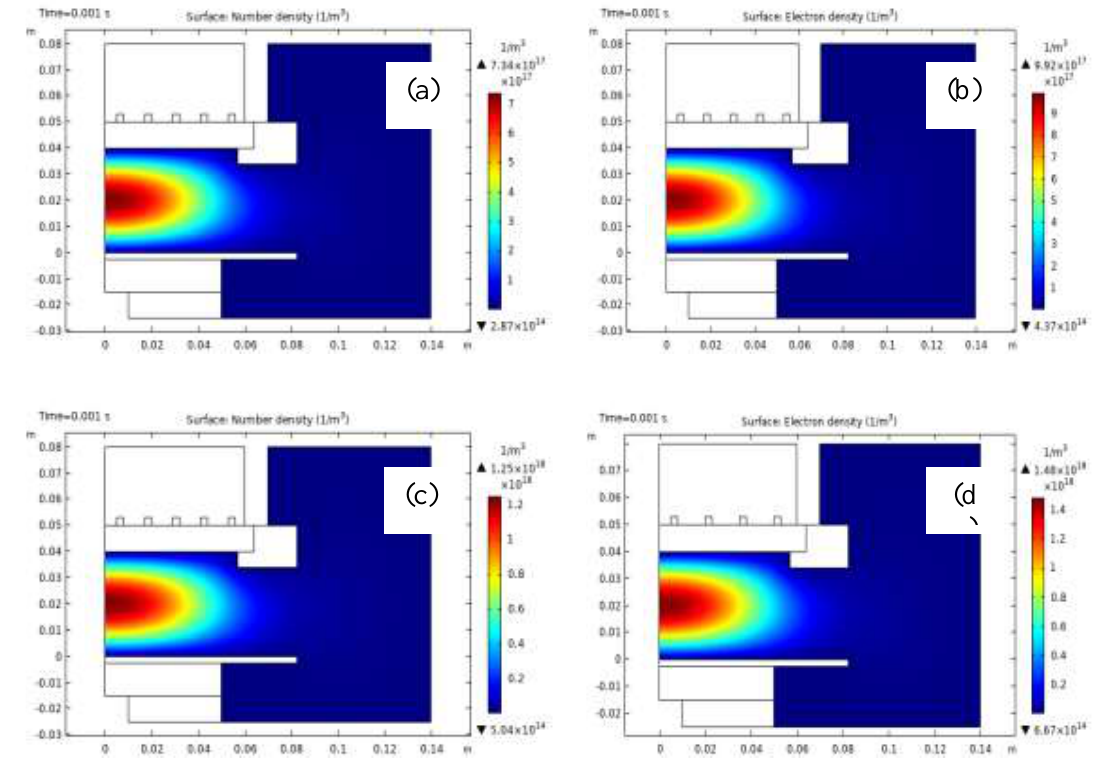
Figure 6: Ion number density distribution at different power input values; (a)750W, (b) 1000W, (c) 1250W, (d)